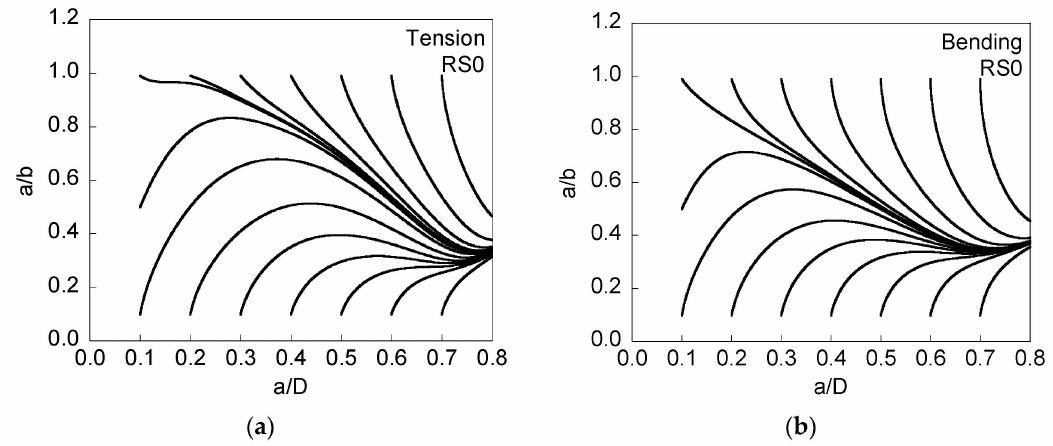
Figure 3. Evolution of the aspect ratio a / b with crack growth (represented by the relative crack depth a / D ) for RS0, cyclic tension loading ( a ); and cyclic bending moment ( b